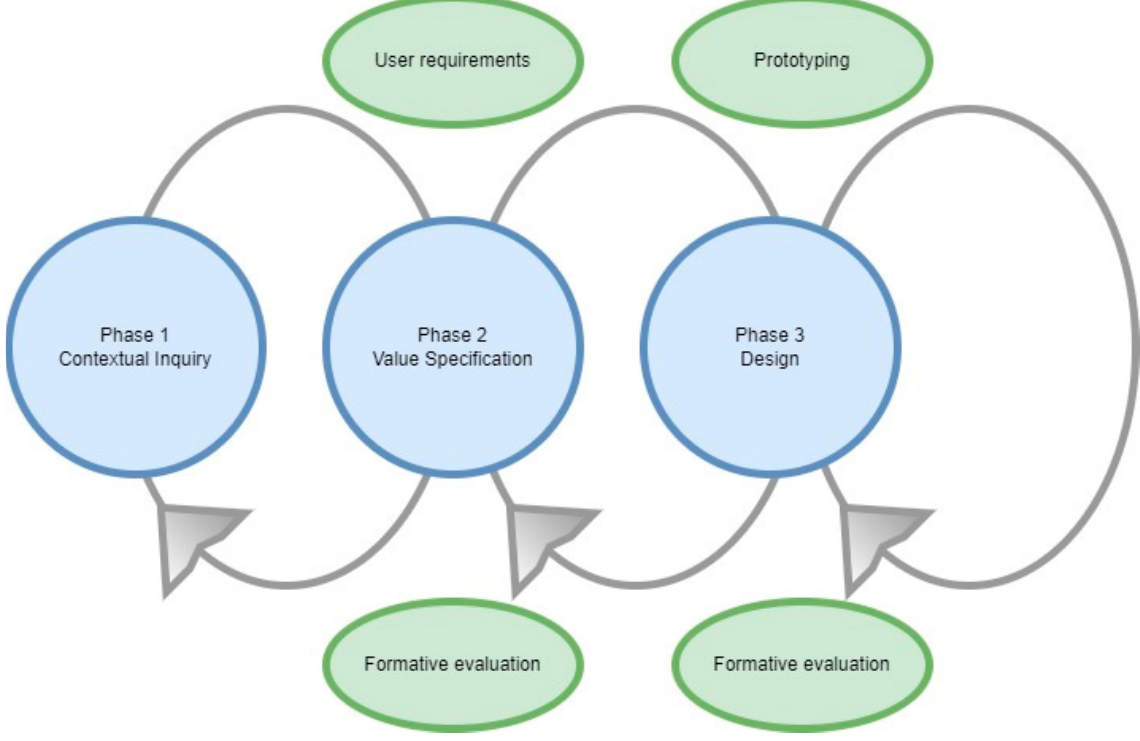
Figure 1. Phases of the CeHRes Roadmap.